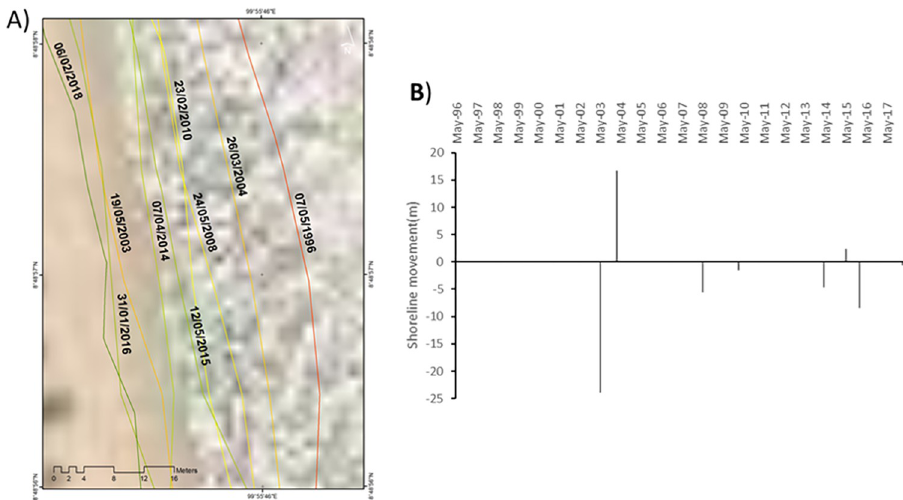
Fig 8. Representations of the shoreline movements observed during the survey period in site 3. A) Visualisation of the shoreline positions for the highest water level marks digitised with CoastSat. B) Shoreline movements measured using DSAS between two consecutives chronologically ordered digitised shorelines; negative values correspond to erosion and positive values to accretion. Basemap satellite images accessed from World Imagery ESRI Tile Layer. Credits: Esri, Maxar, GeoEye, Earthstar Geographics, CNES/Airbus DS, USDA, USGS, AeroGRID, IGN, and the GIS User